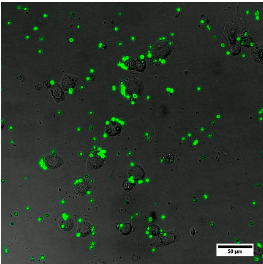
Figure 4. General view of the MDA-MB-468 human breast adenocarcinoma cells interacting with the antibody-functionalized, quantum dot-encoded microcapsules. Photonics 2019 , 6 , x FOR PEER REVIEW